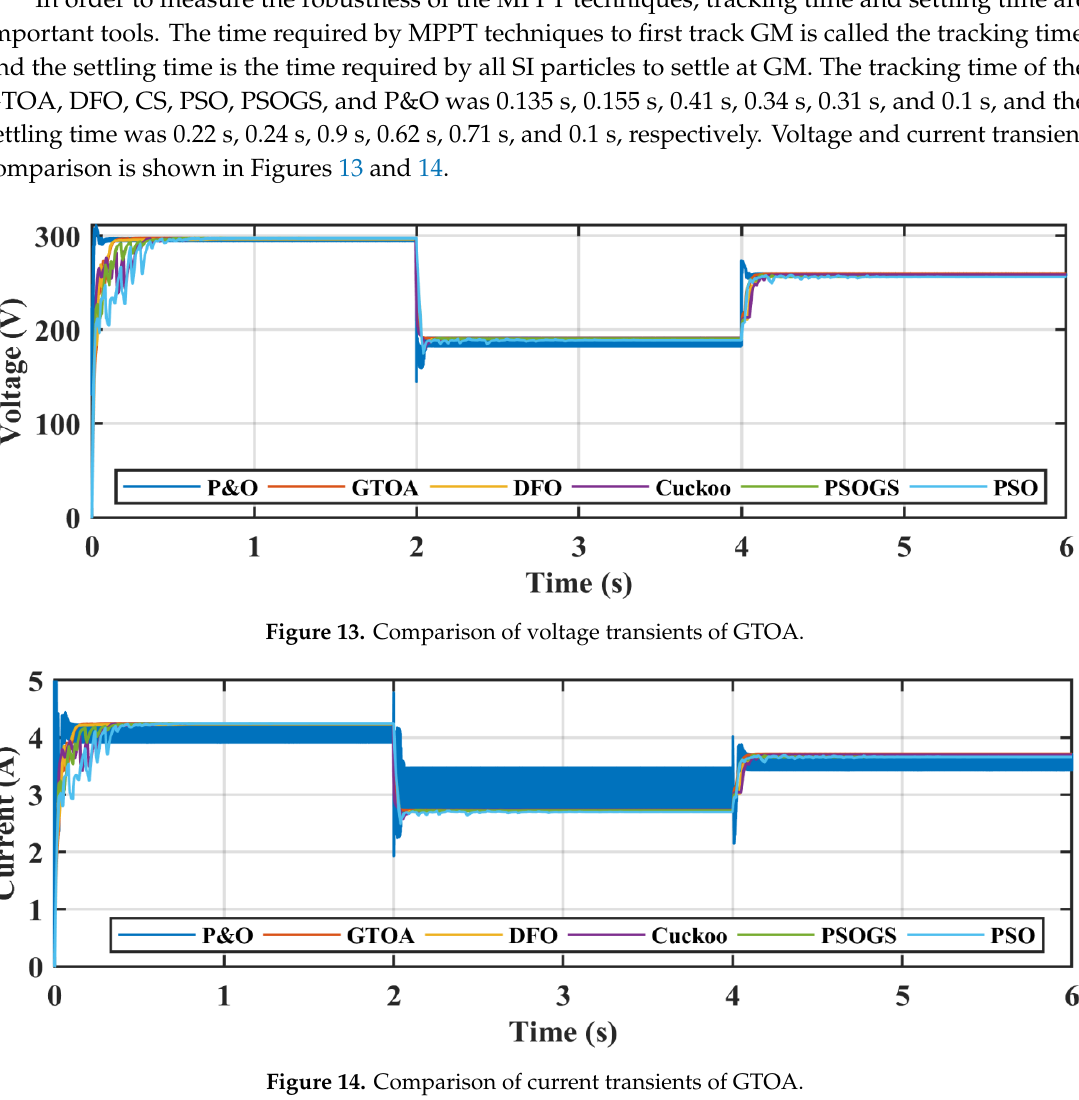
Figure 12. Zoomed-in comparison of duty cycle of GTOA.